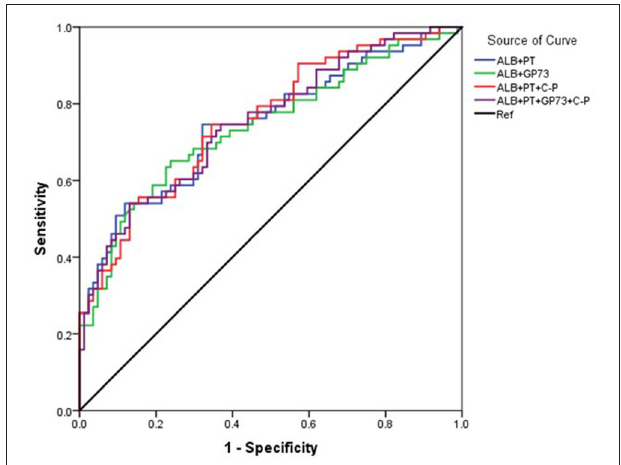
FIGURE 2 | Diagnostic accuracy of parallel combination of variables for the prediction of esophageal variceal hemorrhage. The ROC curve was used to represent the prediction model for hemorrhage using multiple clinical markers, with the AUC indicating the value of the prediction model. Different colors represent different predictors. The ROC curve was plotted based on the data in Table 4 . Blue: ALB + PT, Green: ALB + GP73, Red: ALB + PT + (C-P), Purple: ALB + PT + GP73 + (C-P), Black: Reference (Ref).